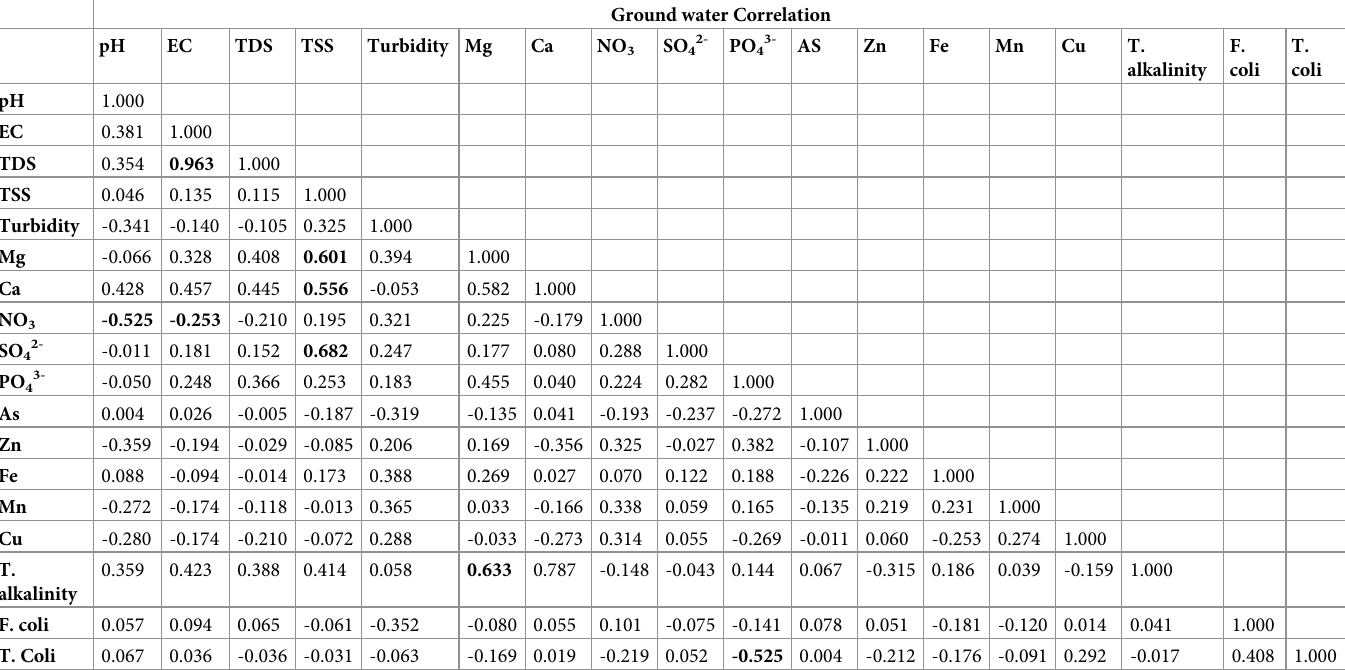
Table 2. Pearson’s correlation matrix for analyzed water quality parameters in groundwater.